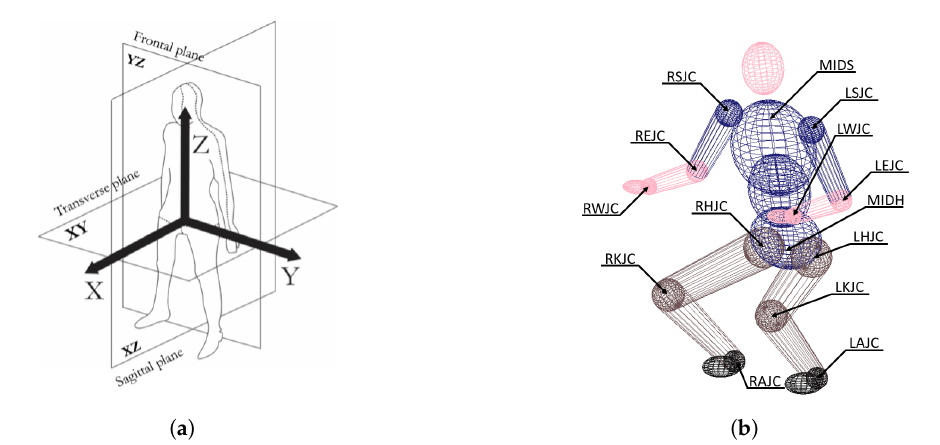
Figure 1. Rider multibody model: reference frame for the whole body [51], with the sagittal ( x ), transverse ( y ), and longitudinal ( z ) axes and planes ( a ); and main points of the multibody model ( b ).